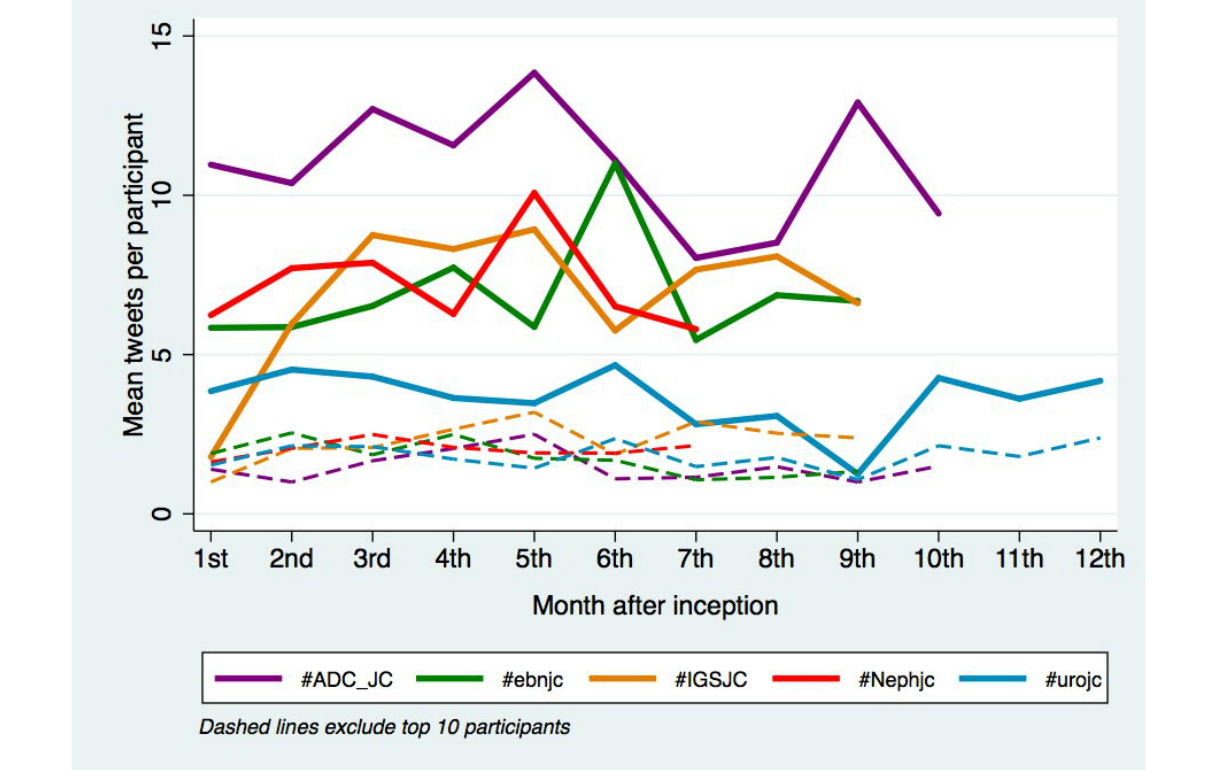
Figure 3. Average tweets per participant for the top 5 journal clubs (#ebnjc, #iurojc, #Nephjc, #ADC_JC, #igsjc). The overall calculated average for each journal club is represented by solid lines, while the average for participants outside of the Top 10 is represented by dashed lines.